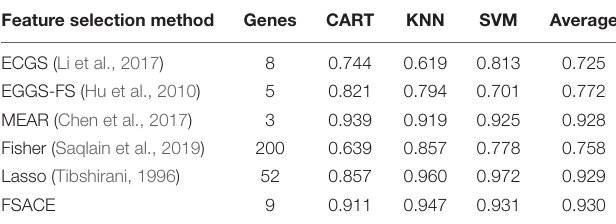
TABLE 4 | Classification accuracy of Leukemia1 using six different feature selection algorithms.